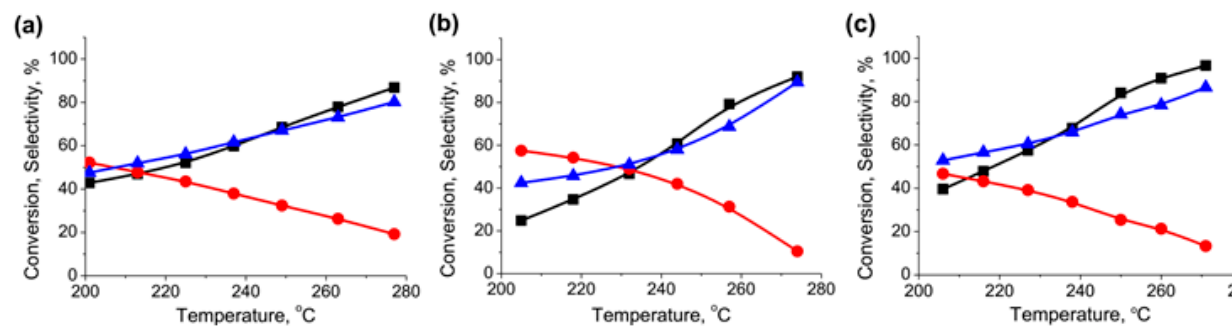
Figure 5. Catalytic performance of ( a ) Co@NC-Gr, ( b ) Co@NC-ZIF and ( c ) Co@NC-ZIF SA catalysts as a function of temperature: conversion of ethanol ( ■ ) and selectivities toward acetaldehyde ( ● ) and CO + CO 2 ( ▲ ). Gas mixture: 2 vol.% EtOH, 18 vol.% O 2 , He balance; GHSV ≈ 18,000 h − 1 .